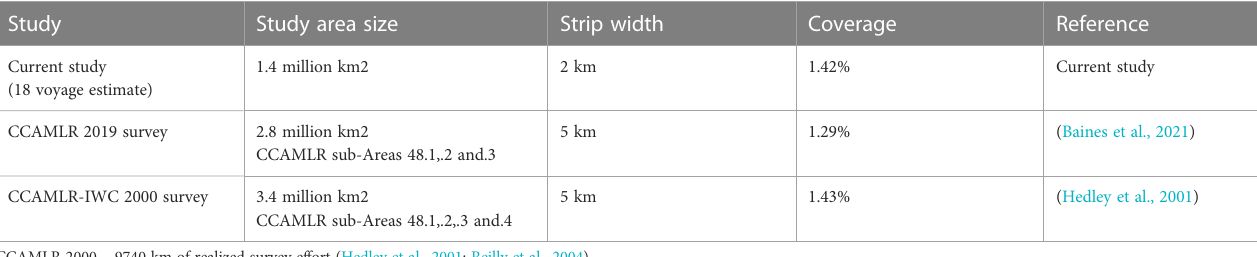
TABLE 2 Comparisons of the searched area between scienti fi c vessel-based surveys and tourist platform-based surveys.